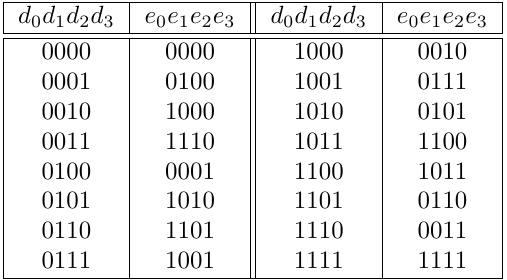
Table 13: The truth table of the inverter over GF (2 4 ) generated by the